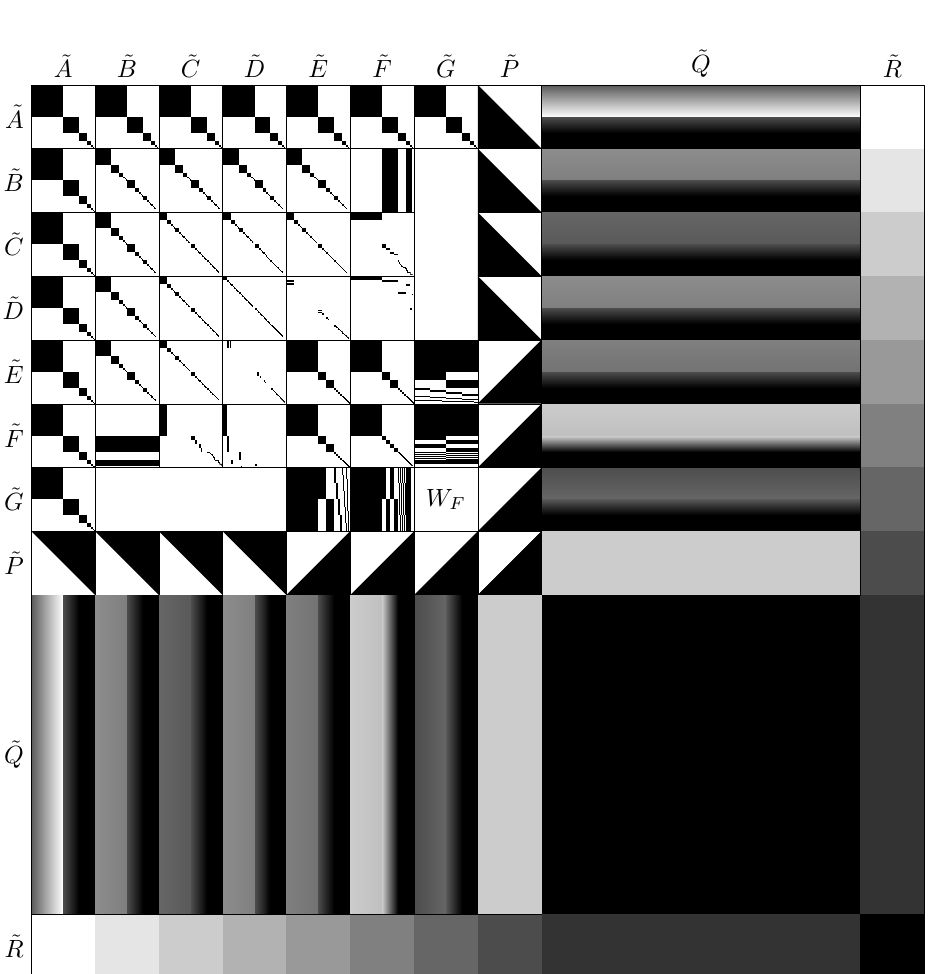
Figure 5: The graphon (cid:101) W 0 constructed in